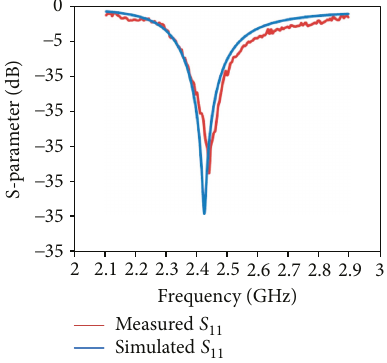
Figure 6: Simulated and measured S -parameter, S